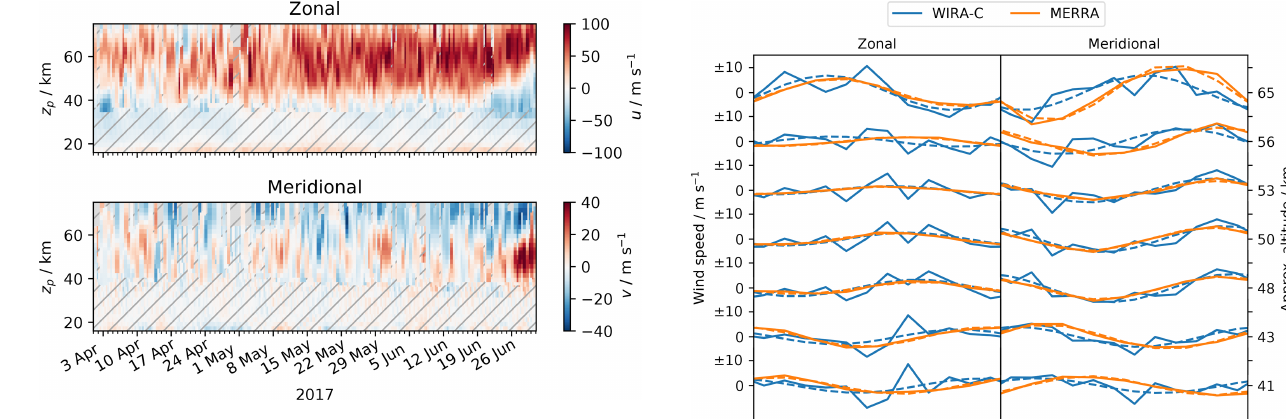
Figure 1. Background wind speed measured by WIRA-C comple- mented with MERRA-2 reanalysis data (hatching) for the tropical campaign. Note the different scales for the zonal and meridional components.